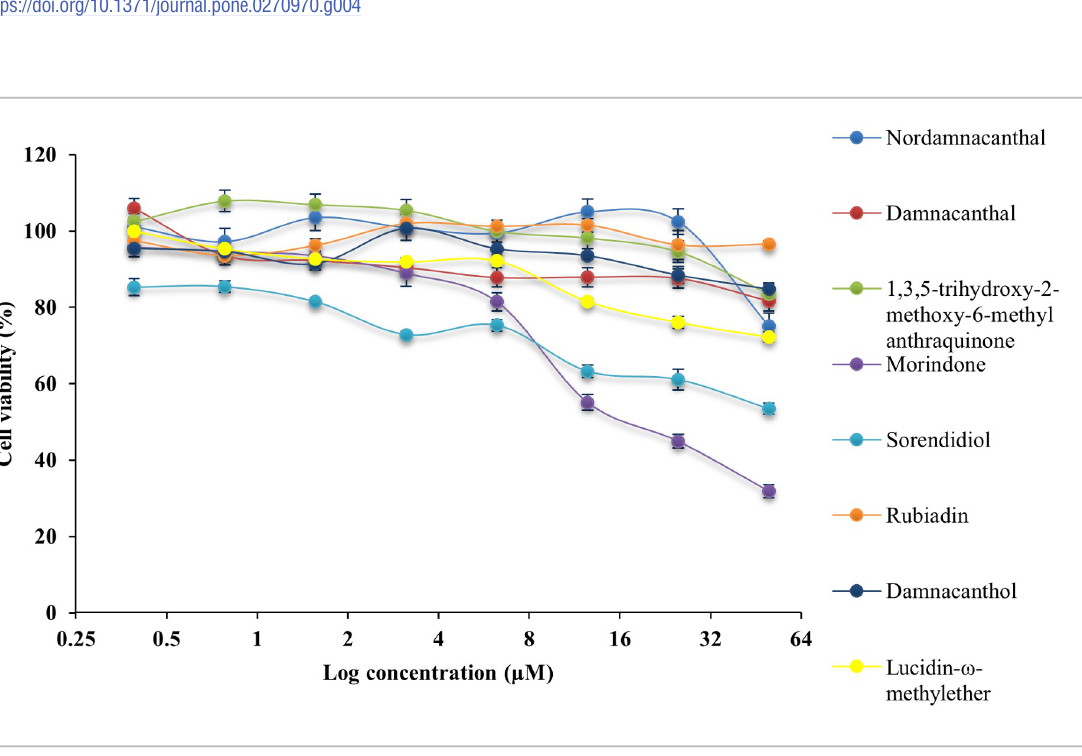
Fig 5. Cytotoxicity effect of anthraquinone compounds 1–8 on the cell viability of LS174T cells. Data was shown as mean ± SD from three independent experiments.